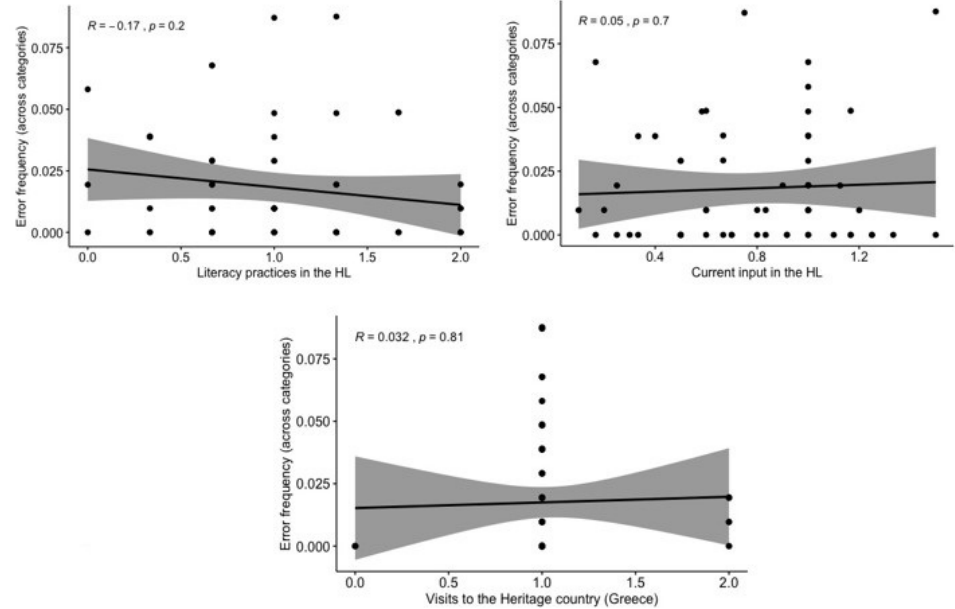
Figure 11. Correlations between frequency of errors across agreement categories and literacy practices in the HL ( up left ), current input in the HL ( up right ) and visits to the Heritage country ( down ) within the USA group.